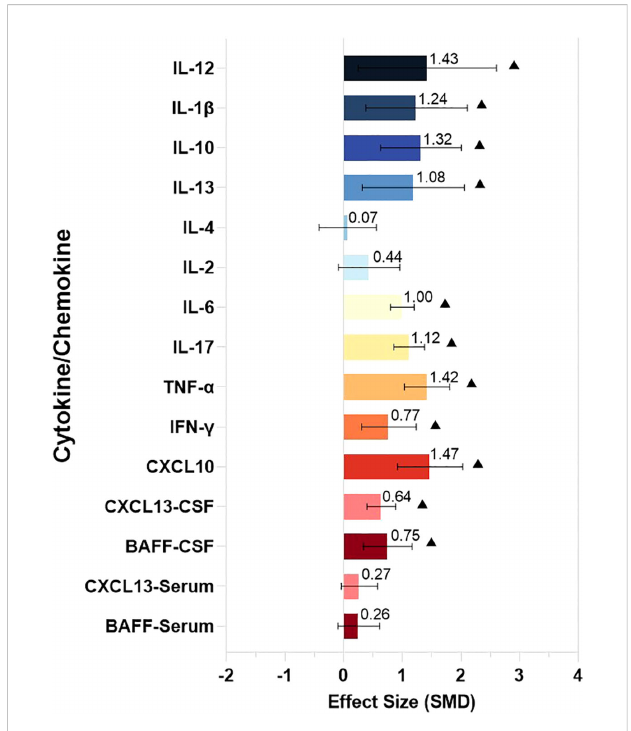
FIGURE 2 The comparison of CSF and serum levels of the cytokines/chemokines in NMDAR-E. Effect size estimates (SMD) and 95% con fi dence intervals are represented by colored bars and black error bars, ▲ represents P < 0.05. SMD, standardized mean difference; Th, T helper; Treg, T regulatory; BAFF, B cell activating factor; CXCL, C-X-C motif ligand; IFN,interferon; TNF, tumor necrosis factor; IL,